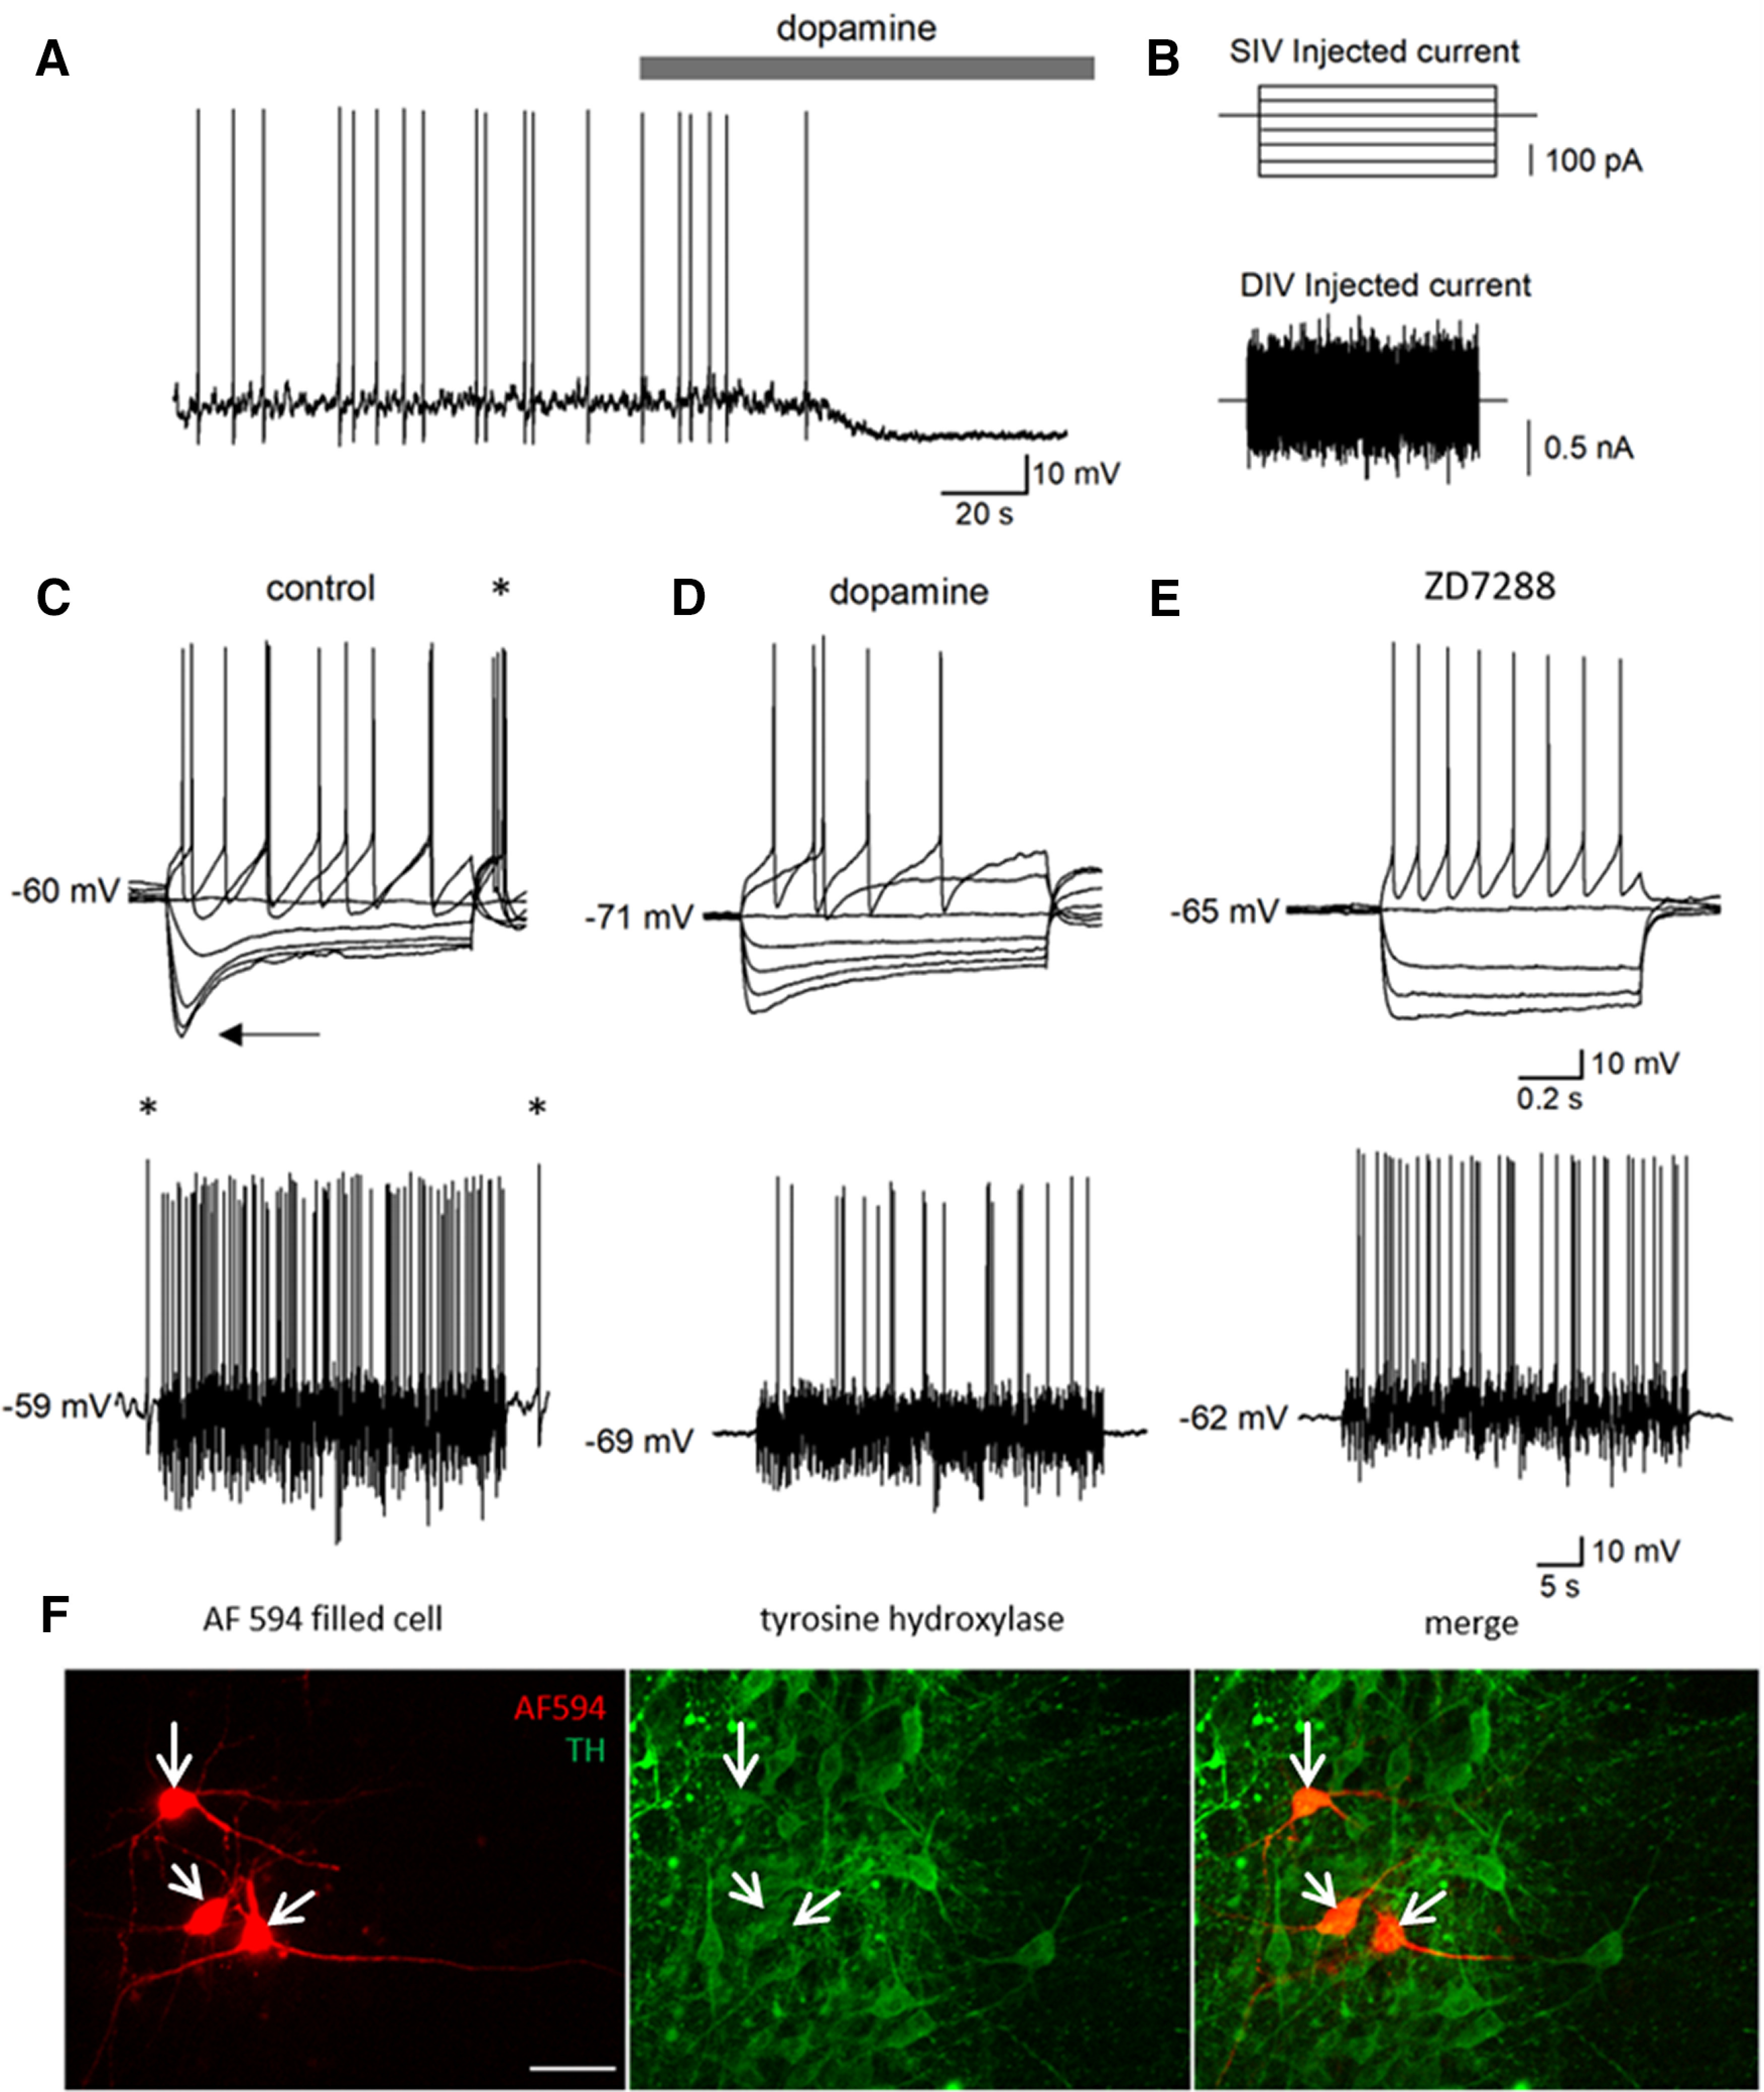
 Whole-cell patch-clamp recording from DNs in the SNpc. A, Example membrane potential trace recorded from a putative DN in the substantia nigra which showed characteristic spontaneous action potential firing. Dopamine (30 μm) hyperpolarized the neuron from −62 to −70 mV and stopped the action potential firing. B, The different input currents delivered to putative DNs. SIV is the standard step current protocol, 3 s duration steps starting at −200 pA and increasing by 50 pA until the neuron exhibits a regular firing pattern. DIV uses a fluctuating naturalistic noisy current trace (for details, see Materials and Methods) which is also used to determine action potential firing rate. C, top, Membrane potential traces in response to current steps. The recorded neuron displays characteristic features of DNs: a large sag in response to hyperpolarizing steps (arrow) and rebound firing (*). Bottom, Membrane potential trace from the same cell in response to naturalistic current injection. The neuron can be seen to be firing at rest (*) which is a characteristic feature of these neurons. D, top, Membrane potential traces in response to current steps following application of dopamine (30 μm). The sag is reduced, the membrane potential hyperpolarized, the firing reduced, and the rebound firing is absent. Bottom, Membrane potential trace from the same cell in response to naturalistic current injection in dopamine (30 μm). The neuron has stopped firing at rest, fires less frequently during current application and is hyperpolarized. E, top, Membrane potential traces in response to current steps in the presence of the I(h) blocker ZD7288 (100 μm) are similar to that previously reported for DN (Harris and Constanti, 1995). The sag response to hyperpolarizing current steps is markedly reduced, the resting membrane potential is hyperpolarized, the firing rate reduced and the voltage response following the spike is altered. Bottom, Membrane potential response of the same neuron to the naturalistic injected current in ZD7288 (100 μm). F, Tyrosine hydroxylase (TH) immunohistochemistry confirms that the recorded neurons were DNs. Neurons were filled with AF594 dye (red) via the patch pipette and then slices were stained for TH (green). The merged image shows that the recorded neurons express TH and are therefore dopaminergic. Scale bar: 50 μm.